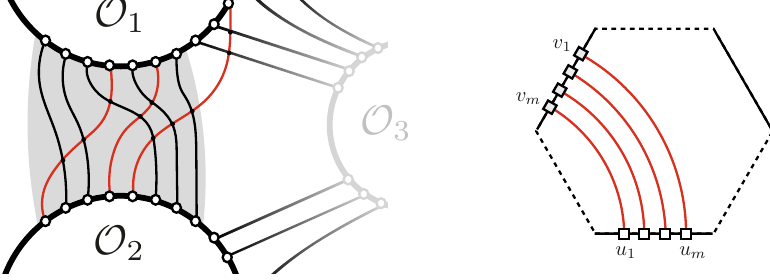
Figure 13 . In the left (cid:12)gure, the bridge overlap between the spiraled operators is represented in gray. Excitations cannot be contracted with the vacuum operator contractions occur in the gray region. On the right (cid:12)gure, we represent the excitation pattern of the hexagon used to compute the bridge